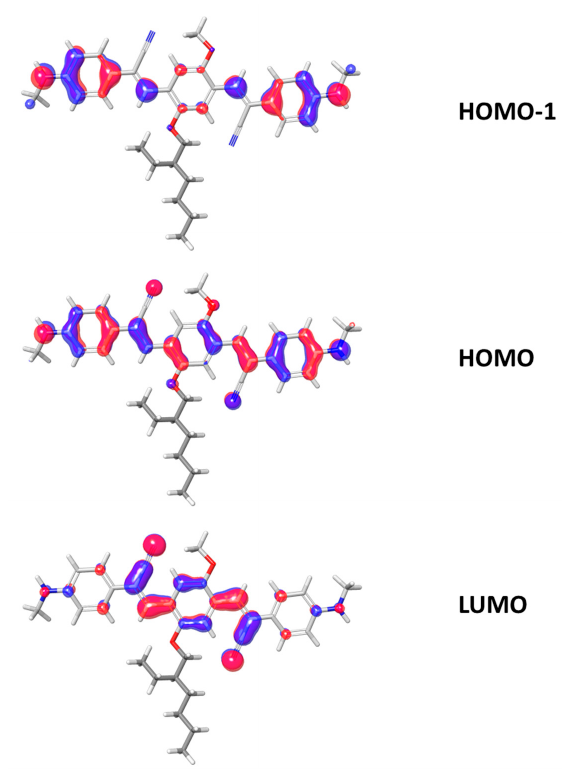
Figure 6. HOMO-1, HOMO and LUMO representation for CN-PV-NHMe.